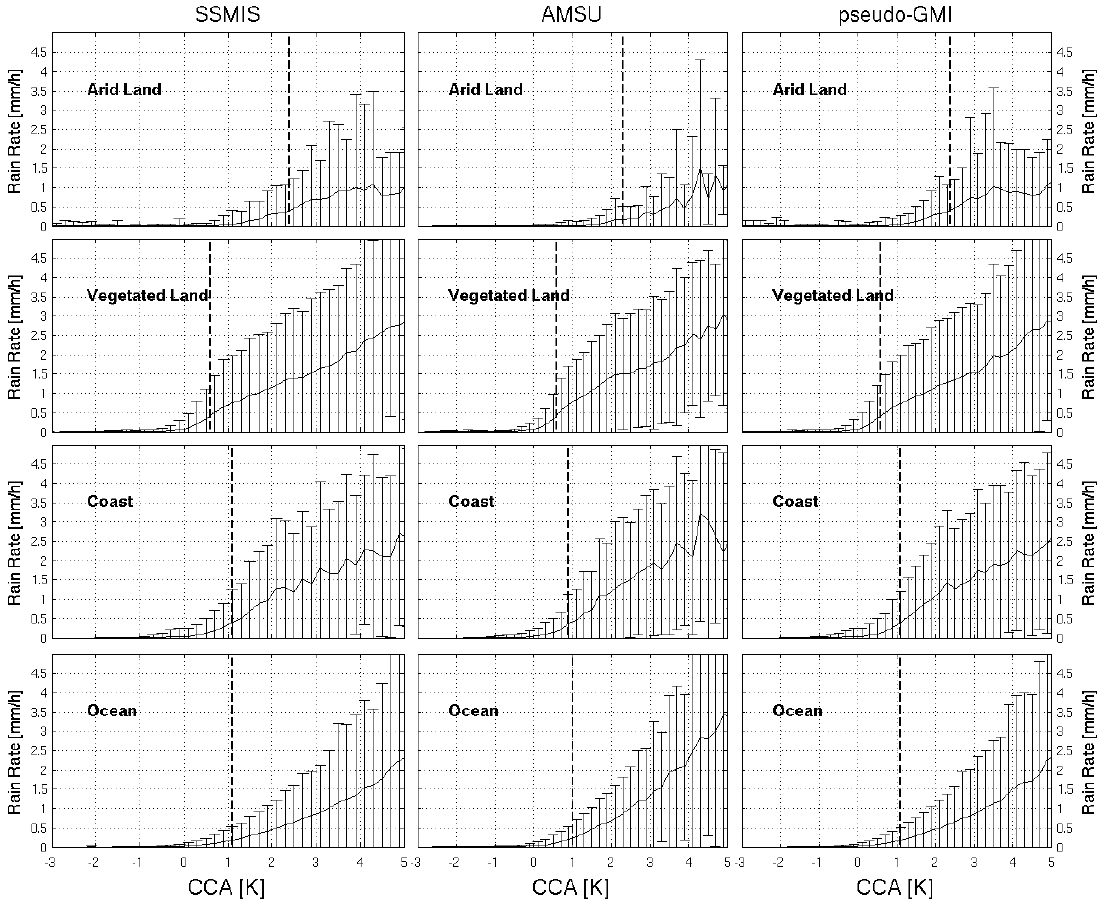
Figure 6. Binning analysis of the rain rate intensity against CV values: mean (continuous black line) and standard deviation (error bars) of rain rates inside an interval of CV bins (as large as 0.2K) are shown. The vertical dashed line represents the CV threshold (CVth) chosen for each combination of radiometer and surface